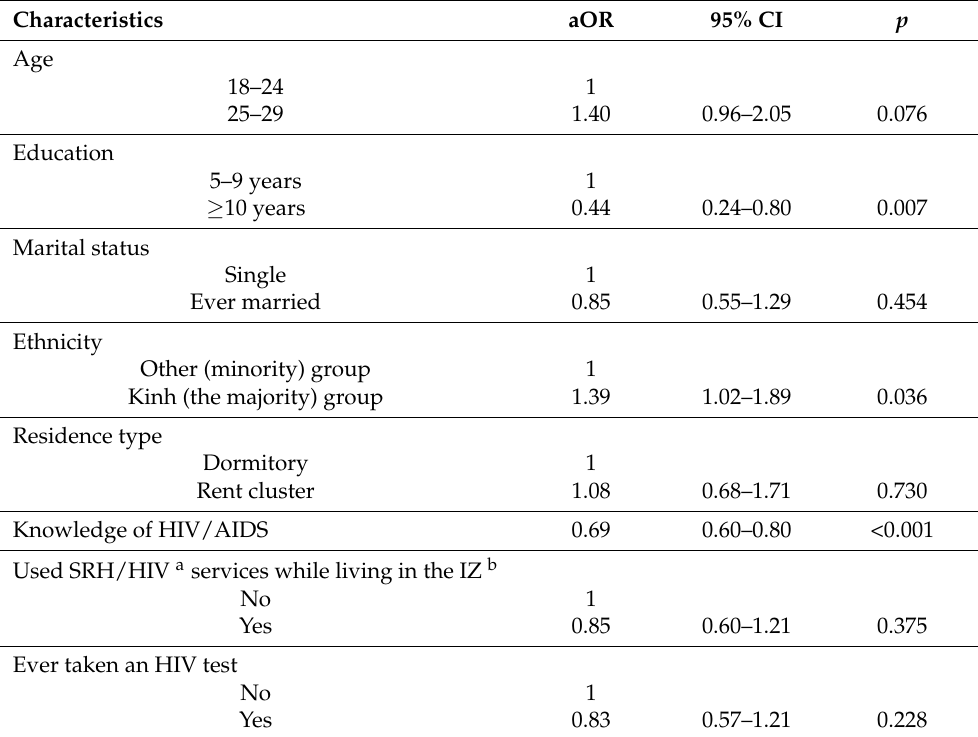
Table 4. Factors associated with stigmatizing attitudes toward PLWH among women migr- ant